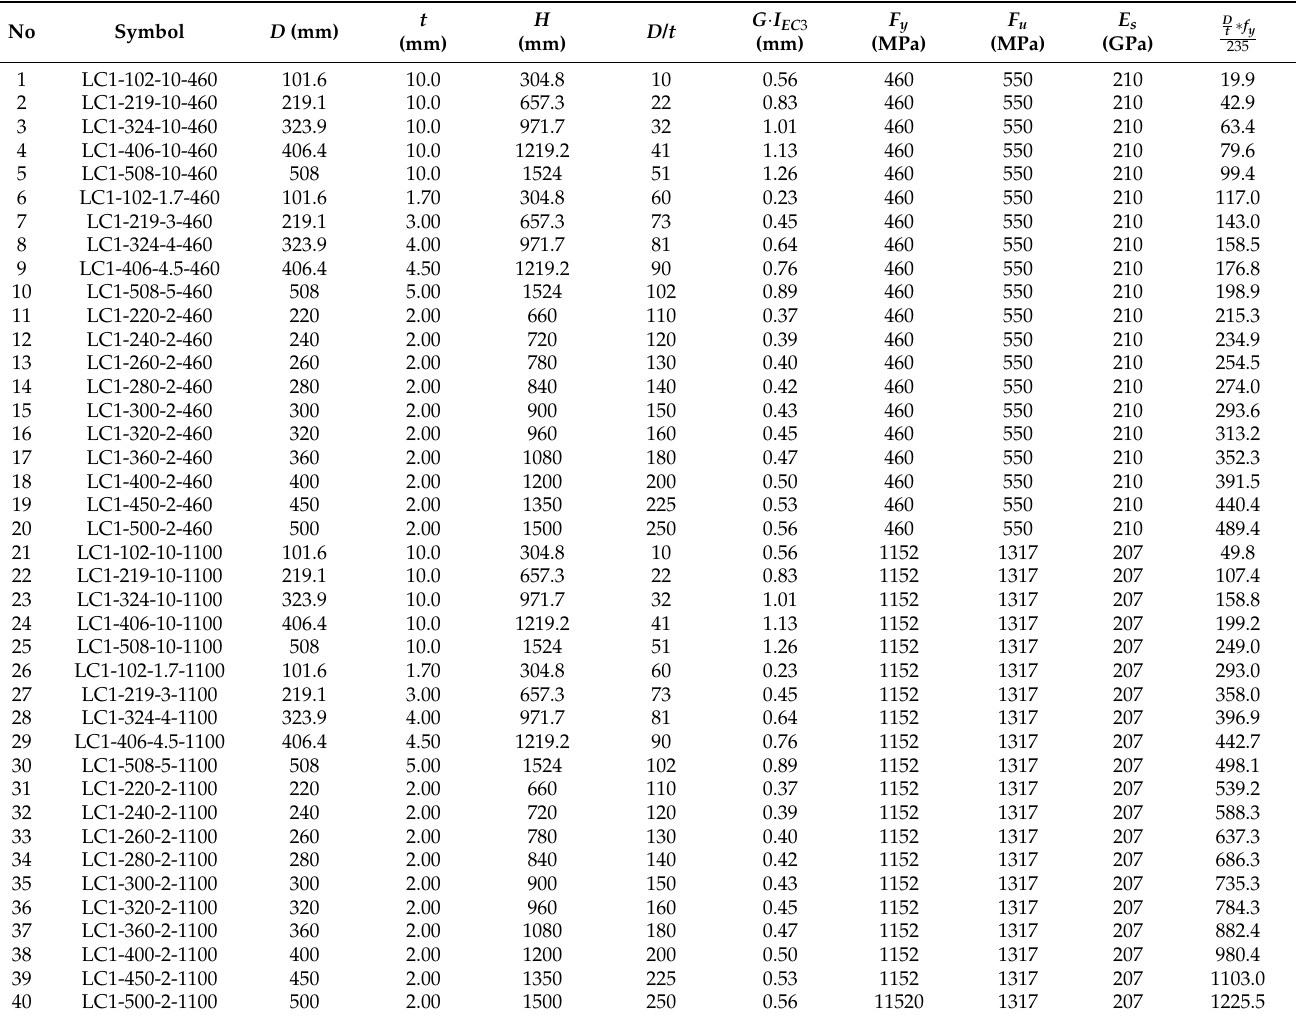
Table 3. Dimensions and properties of the studied CHS high and very high strength steel stub